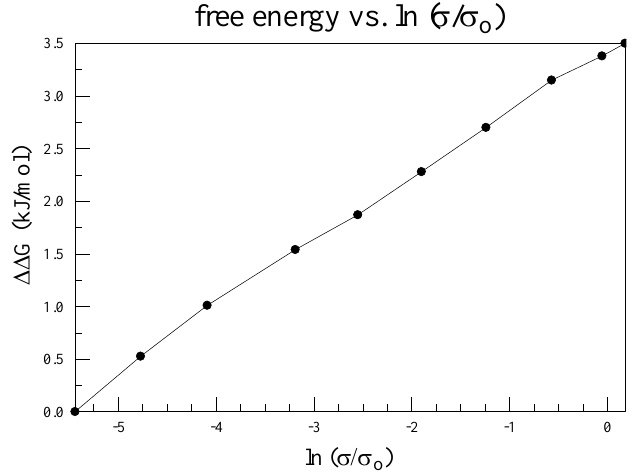
Figure 3. The conductivity of the KcsA channel, like other potassium channels, is proportional to the log[K + ], hence to the free energy of the potassium ion in solution. Reprinted from Kariev and Green